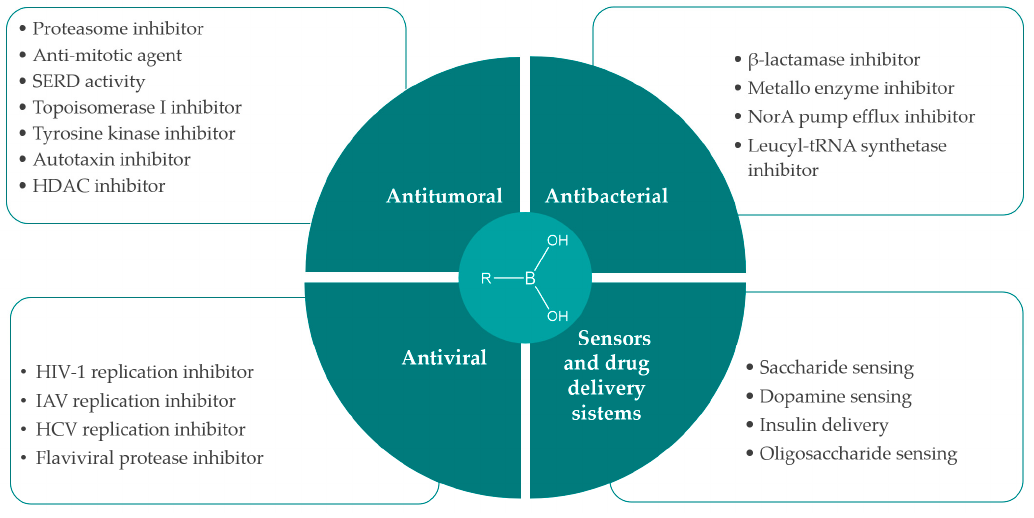
Figure 13. Biological applications and respective activities of boronic acid derivatives.